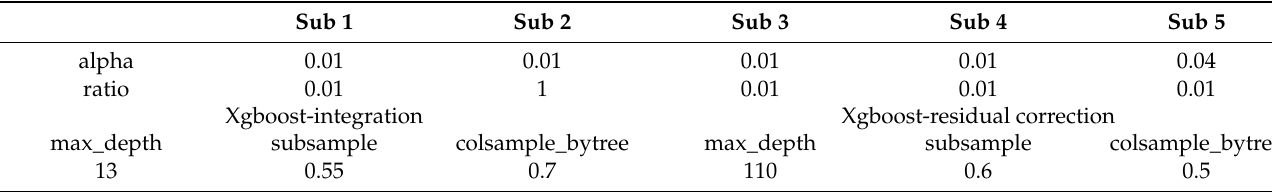
Table 6. Parameters used in case 4.